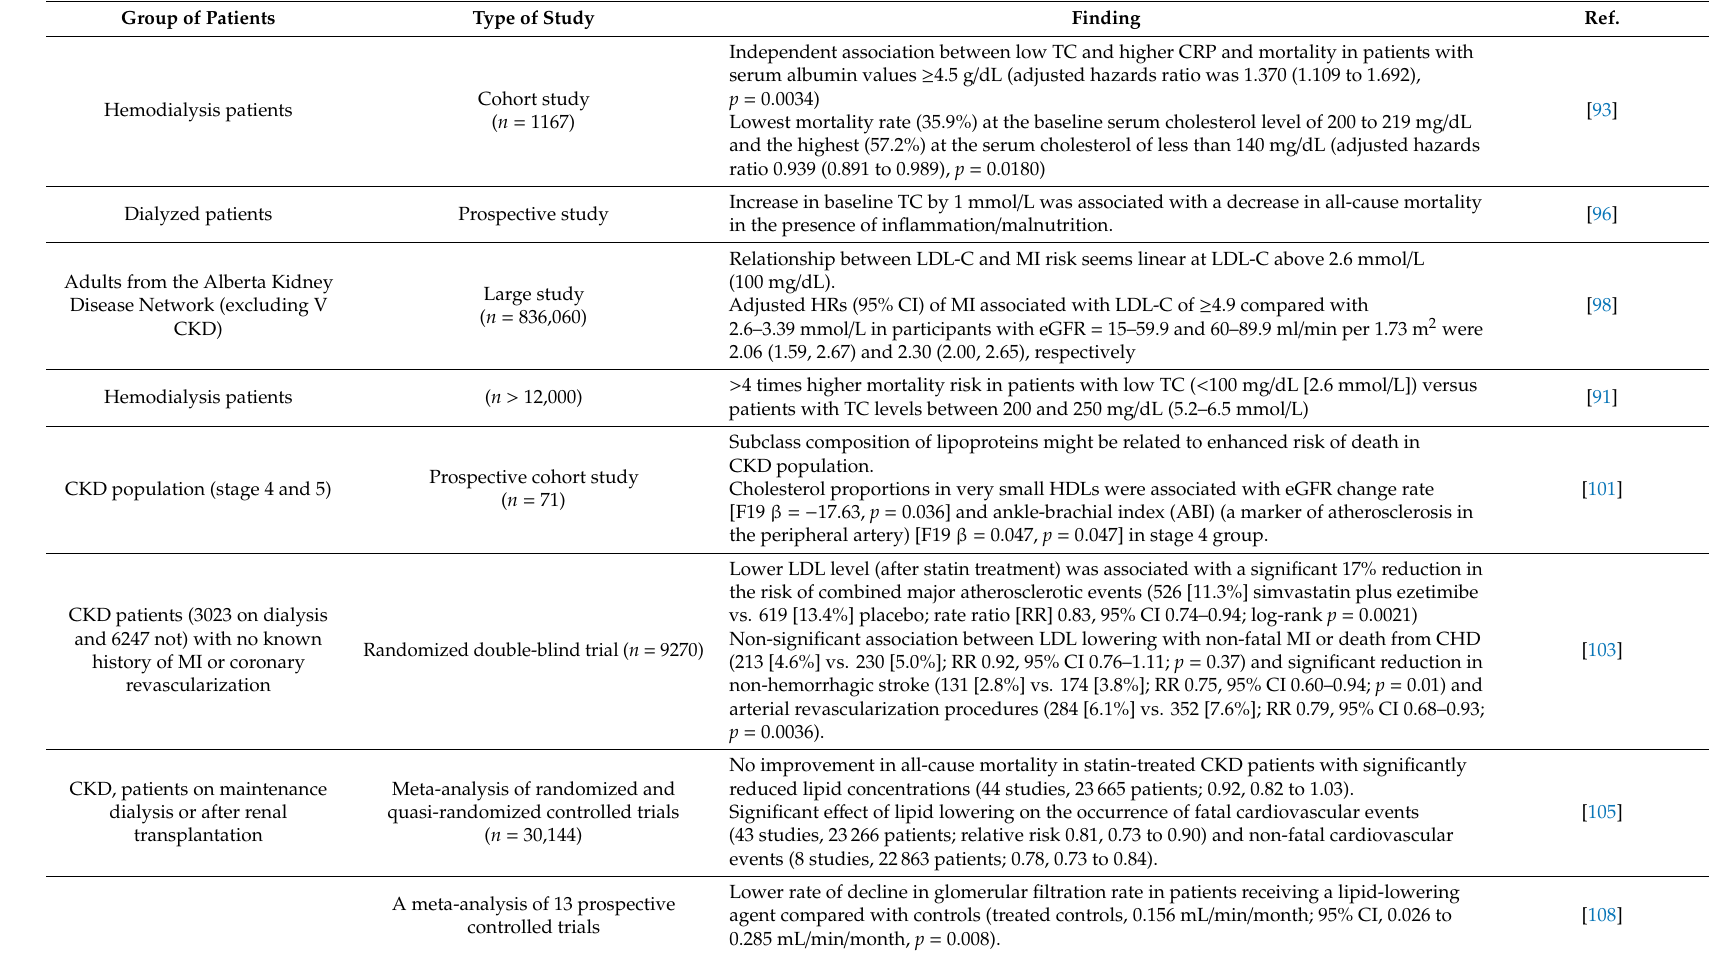
Table 1. The summary of results of studies concerning lipid disorders in chronic kidney disease